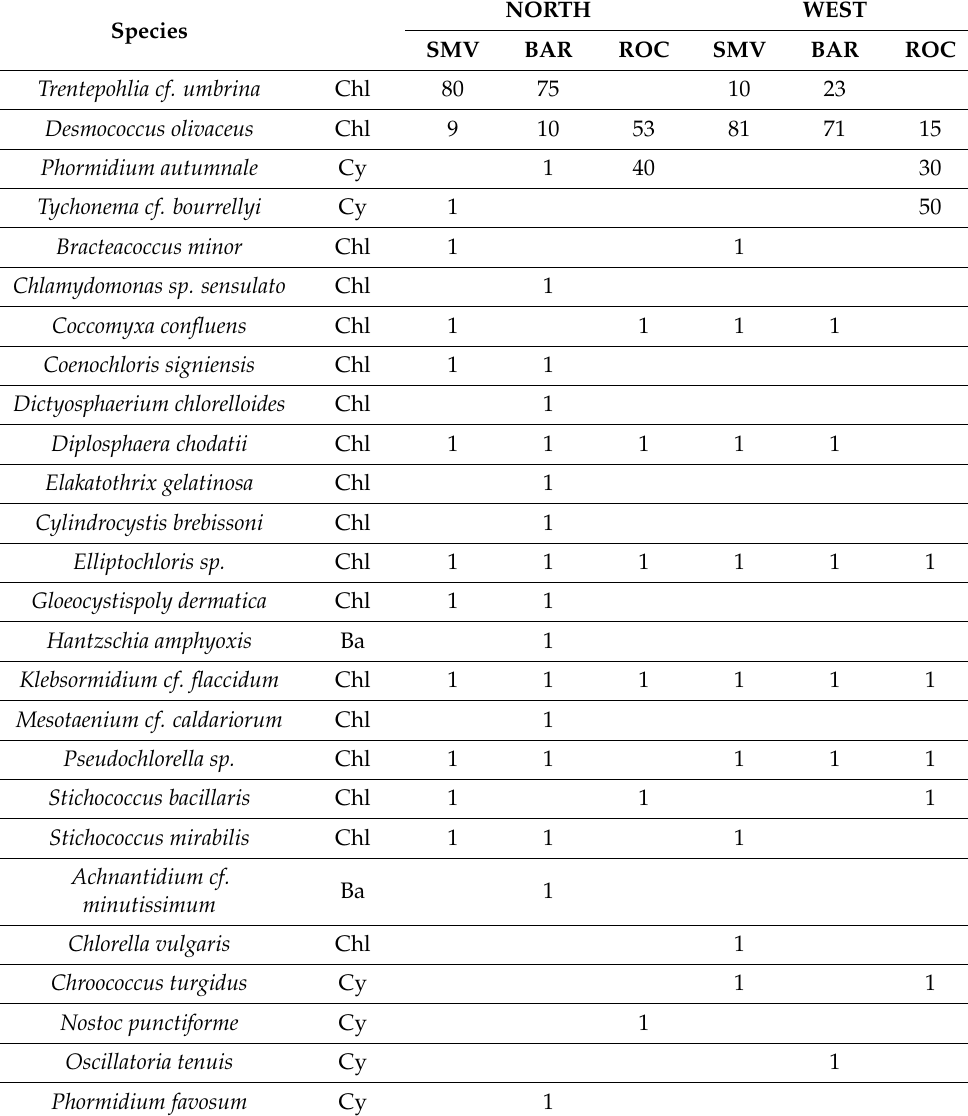
Table 1. Species composition of the phototrophic communities on the SMV, BAR, and ROC churches, expressed as relative frequencies (%) of the total number of cells observed. NORTH WEST Species SMV BAR